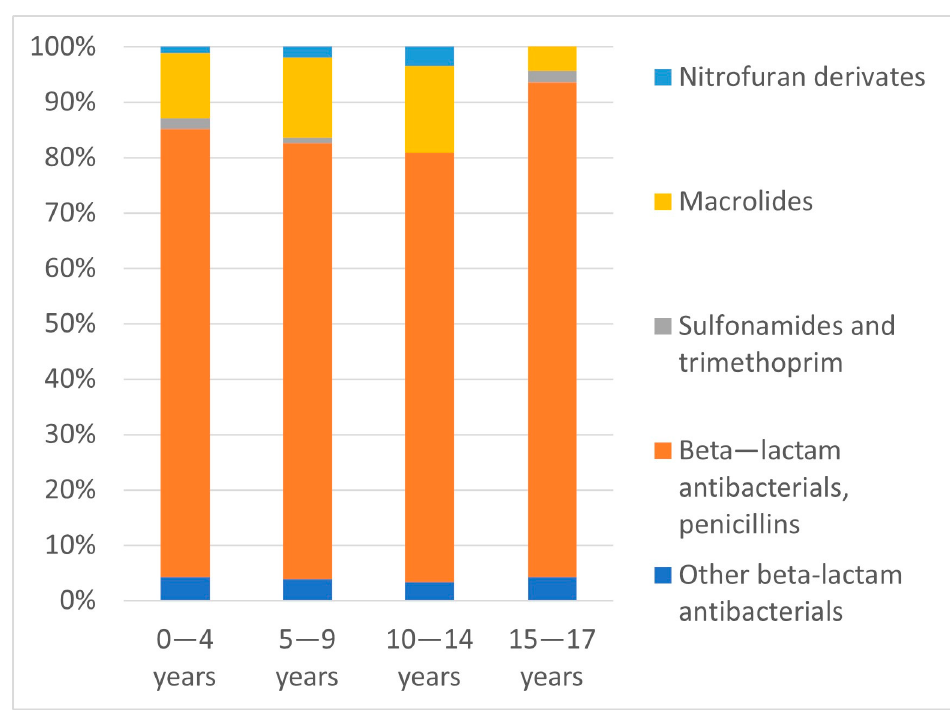
Figure 3. Proportions of prescribed antibiotic subgroups (%) relative to patient age groups.